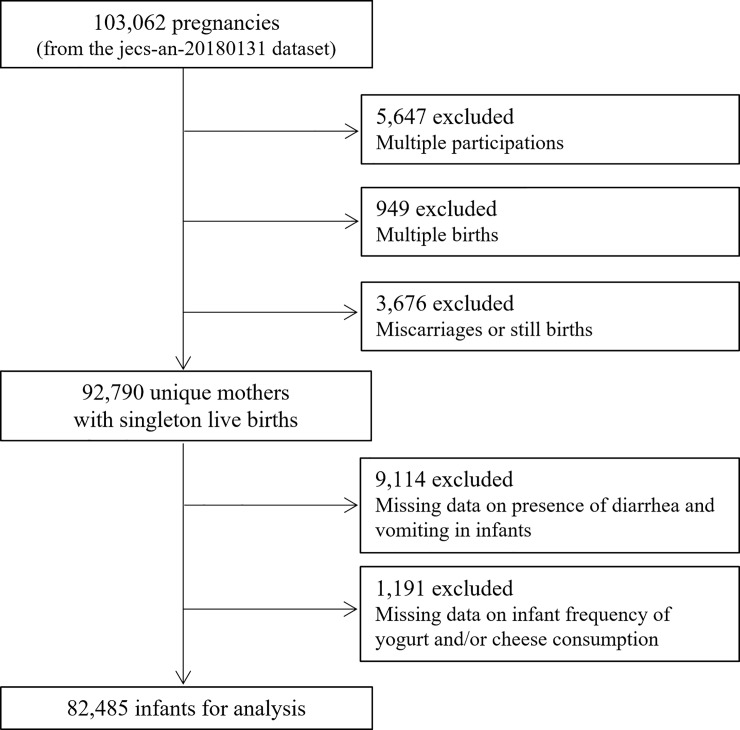
Flow diagram of the recruitment and exclusion process in this study.